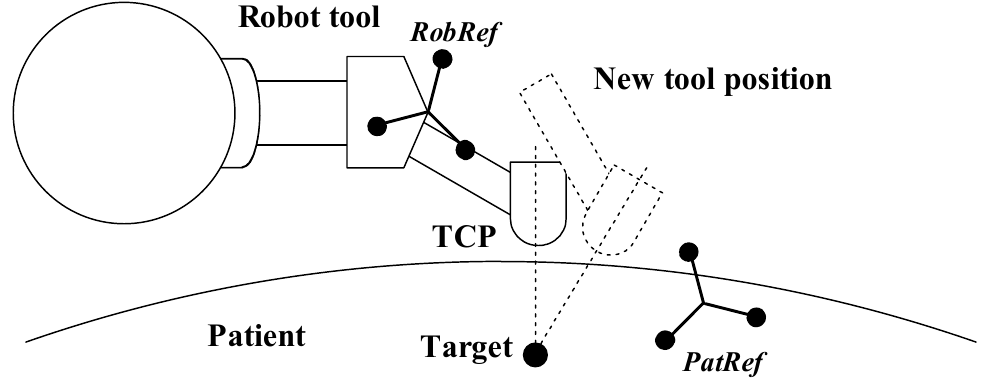
Figure 15. In automatic orientation mode the robot orients the TCP in relation to the target every time after a joystick movement is performed. If the patient moves, the robot will react and compensate for patient movement and will point again to the